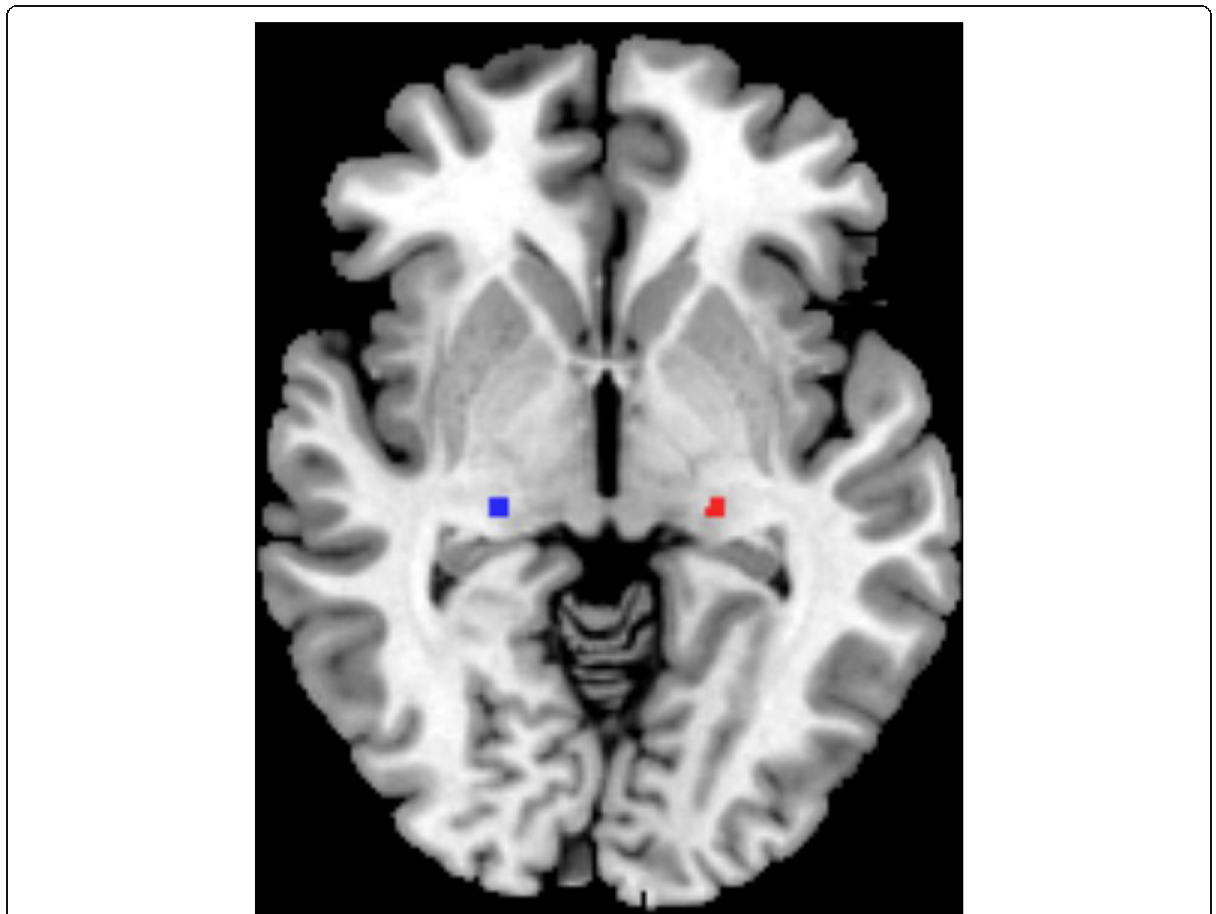
Fig. 1 The bilateral lateral geniculate nucleus masks were generated using the WFU PickAtlas software. Red, left lateral geniculate nucleus; Blue, right lateral geniculate